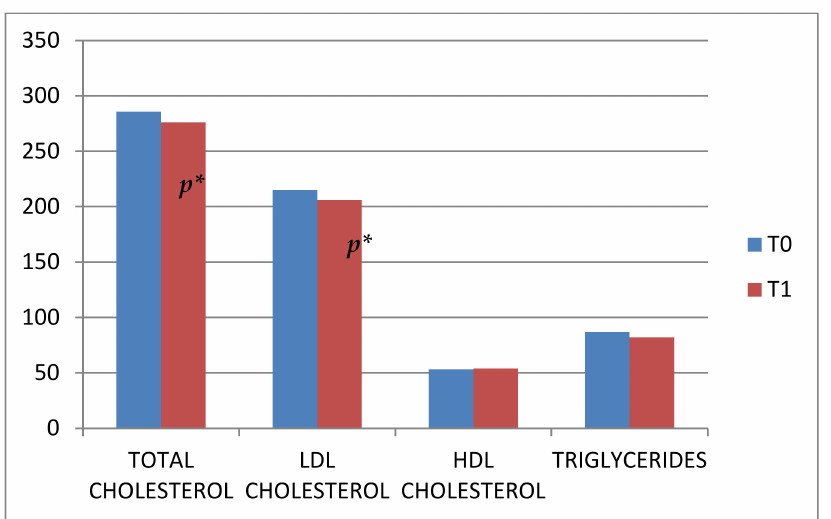
Figure 2. The percentage changes in total cholesterol, low-density lipoprotein cholesterol (LDL- C), high-density lipoprotein cholesterol (HDL-C), and triglyceride concentrations at T0 and T1. * Statistical significance is considered at a p value ≤ 0.01. Data are expressed in mg/dL.